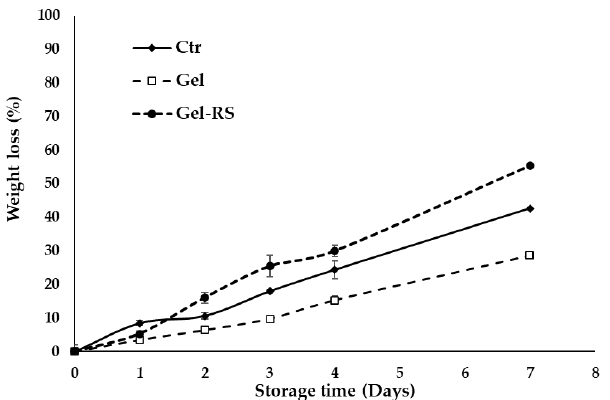
Figure 1. Daily weight loss (%) of coated fresh cut zucchini samples during a 7-day storage period at 5 °C. Sample analysis was in triplicate.